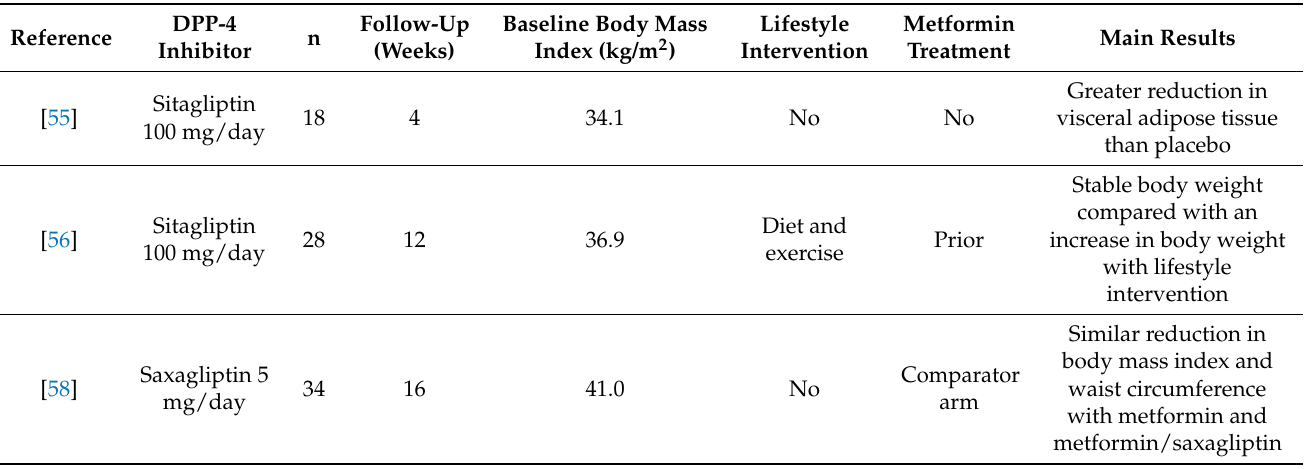
Table 2. Major studies evaluating the effects of dipeptidyl peptidase-4 (DPP-4) inhibitors on obesity in patients with polycystic ovary